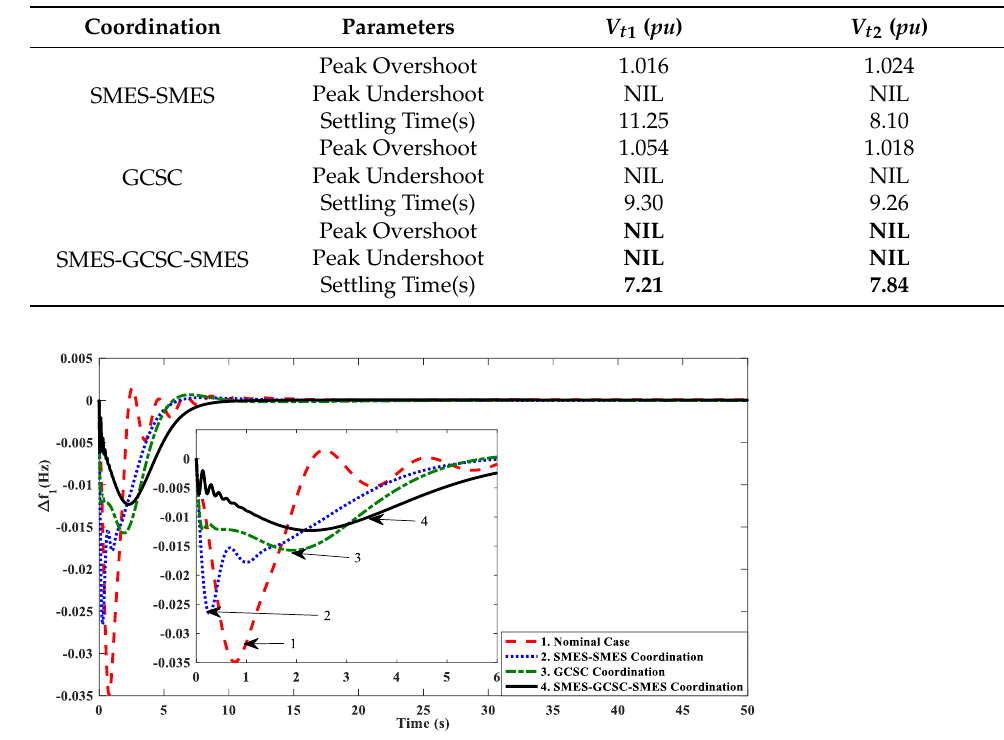
Table 13. SMES-optimized parameters for SMES-GCSE-SMES coordination.